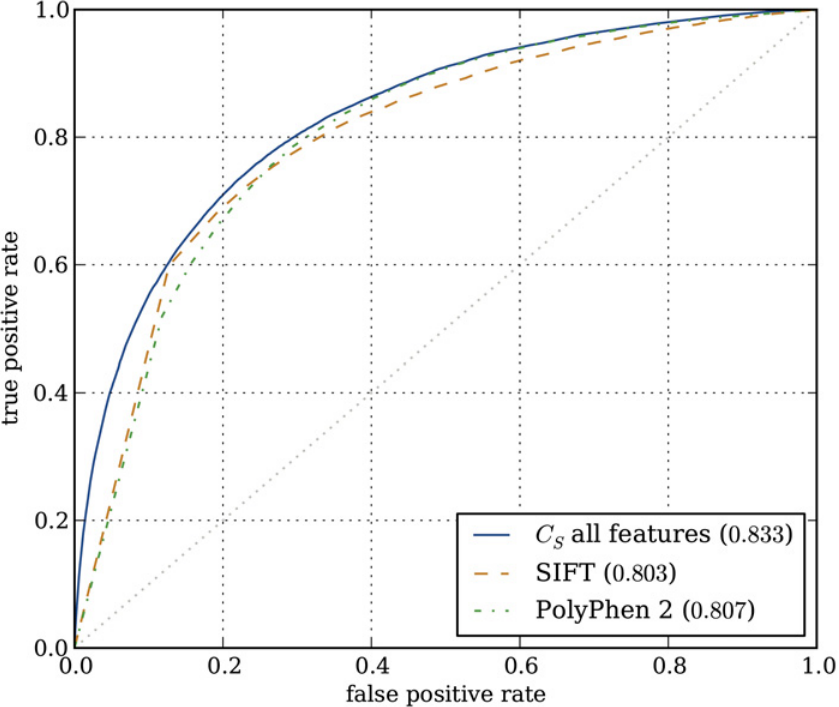
Fig 7. ROC-curves showing classifier performance compared to SIFT and PolyPhen 2. In blue, performance using the combined subset classifier approach ( C S ). In orange and green, performances of SIFT and Polyphen 2